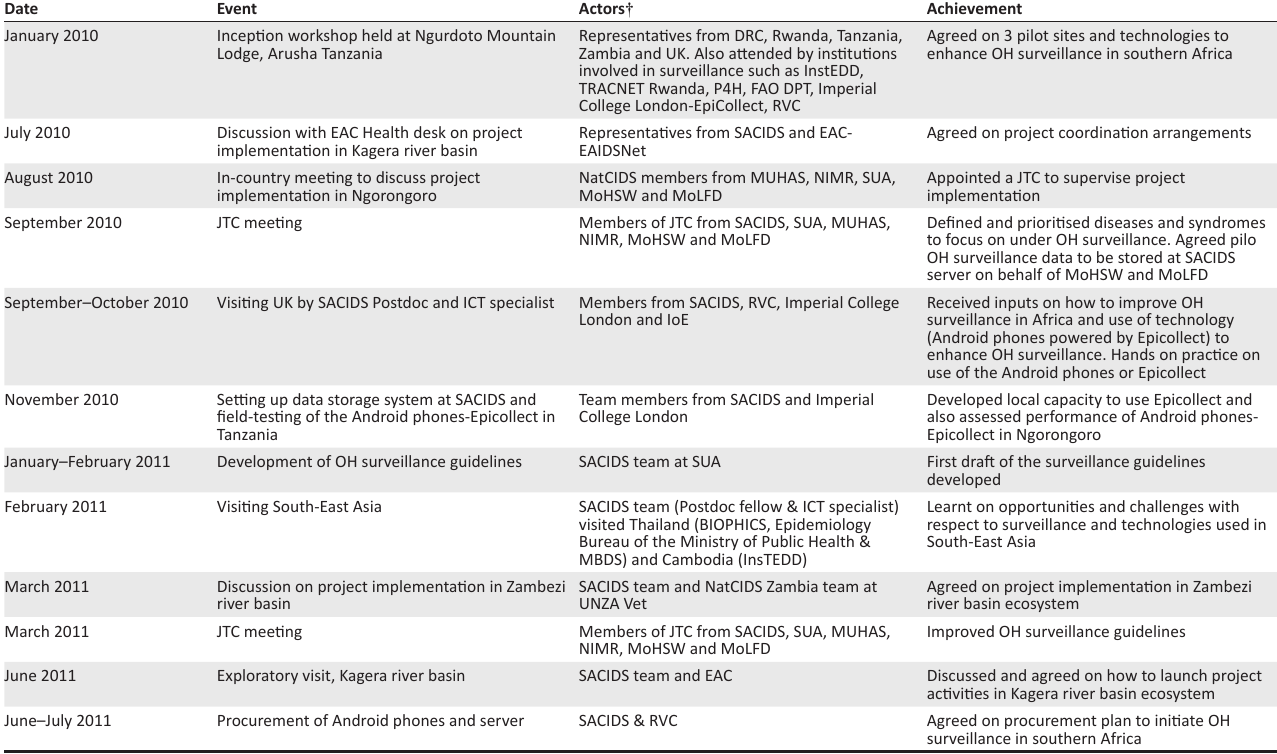
TABLE 3: Timeline of events that contributed to the development of Southern African Centre for Infectious Disease Surveillance One Health surveillance strategy in southern